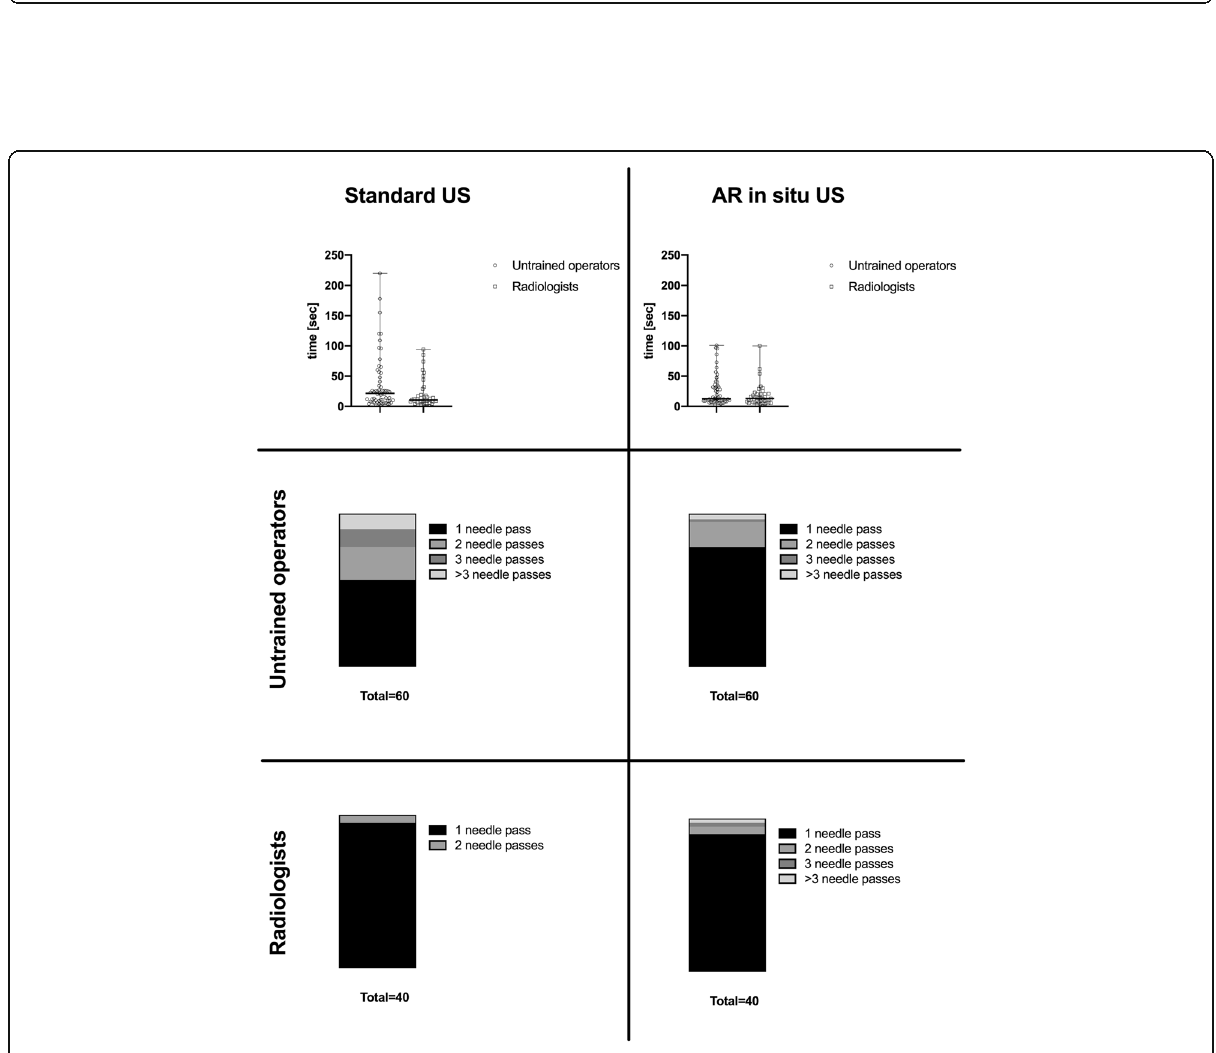
Fig. 6 Experience-based differences using the two different modalities (standard ultrasound versus augmented reality in situ ultrasound technique). Differences in time and number of needle passes to target puncture in untrained operators versus radiologists using standard ultrasound versus augmented reality in situ ultrasound